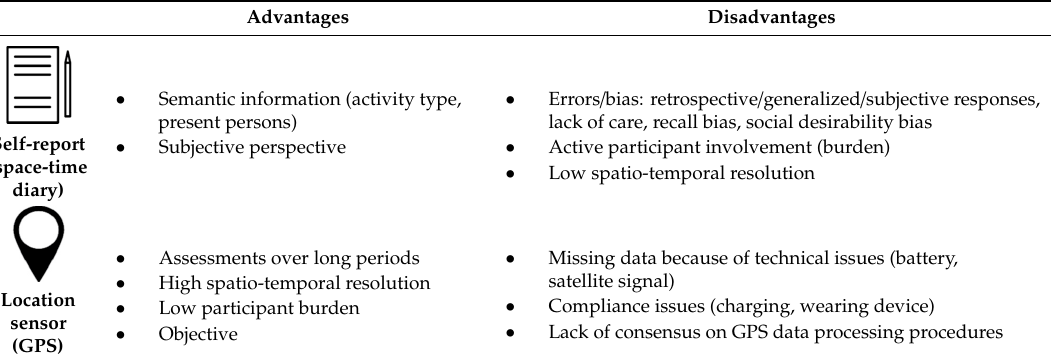
Table 1. Advantages and disadvantages of self-reported diaries vs. location sensors to infer individual’s daily mobility.